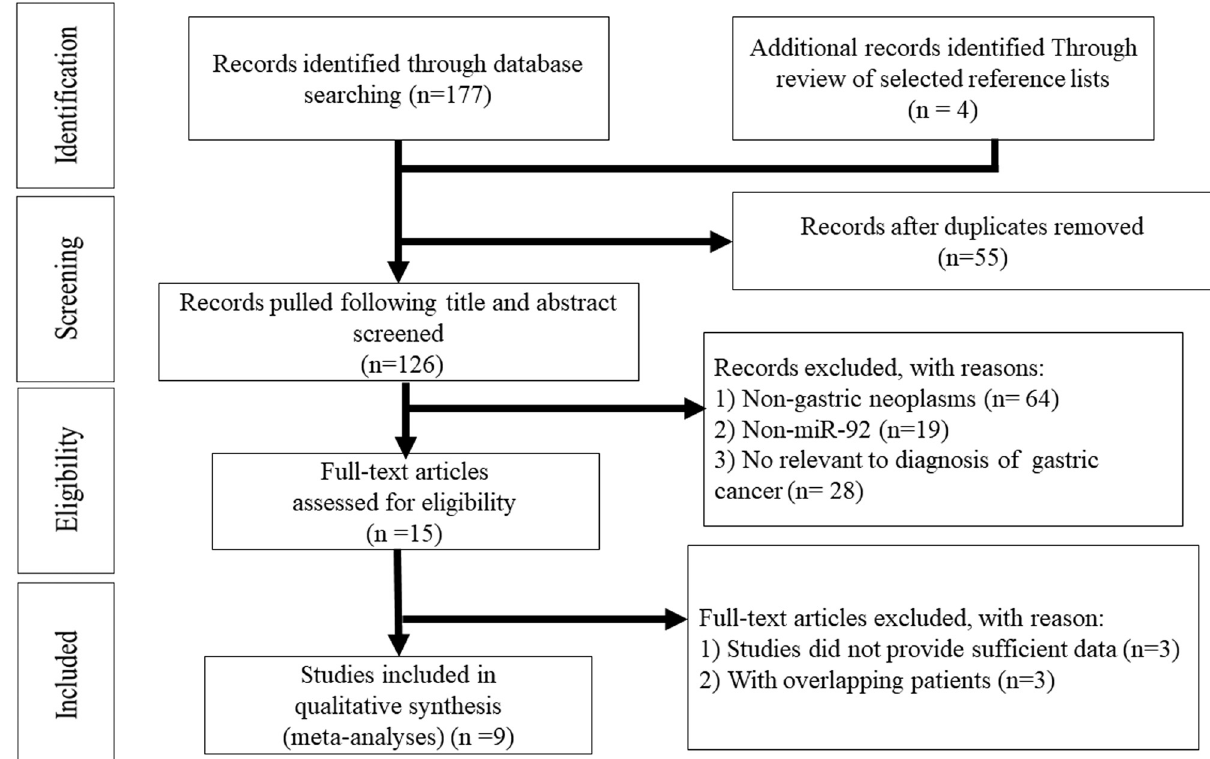
Figure 1: Flow chart of study